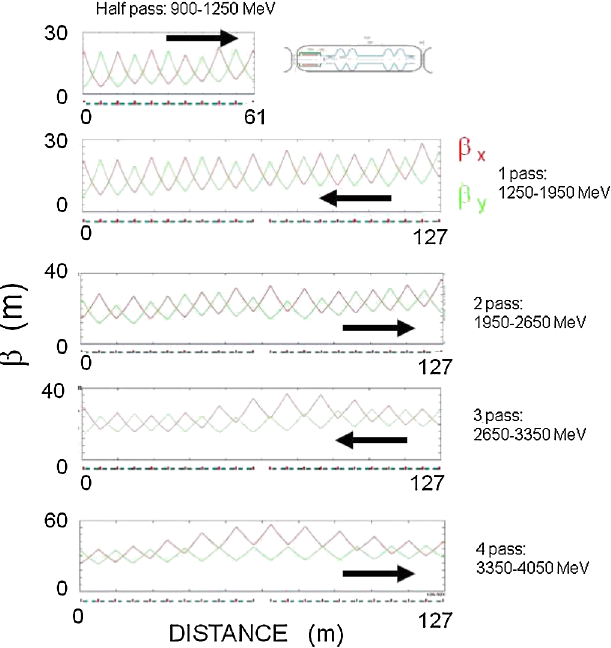
FIG. 9. (Color) FODO based multipass linac optics. The quadru- poles in all cells are set to the same gradient, corresponding to 90 deg phase advance per cell at 0.9 GeV. The betatron phase advance gradually diminishes uniformly in both planes. The resulting linac optics is well balanced in terms of Twiss functions and beam envelopes; there is sufficient phase advance up to the fourth